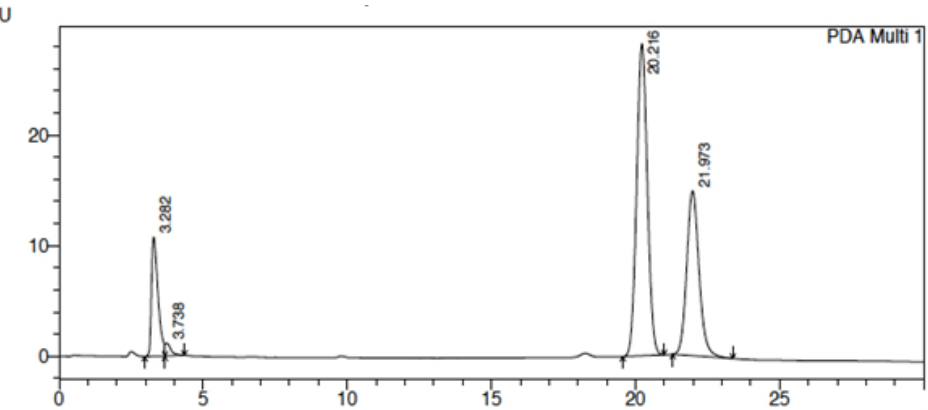
FIGURE 1 - Chromatogram of rutin (3.282 seconds), BMDBM (20.216 seconds), and EHMC (21.973 seconds), all at a concentration